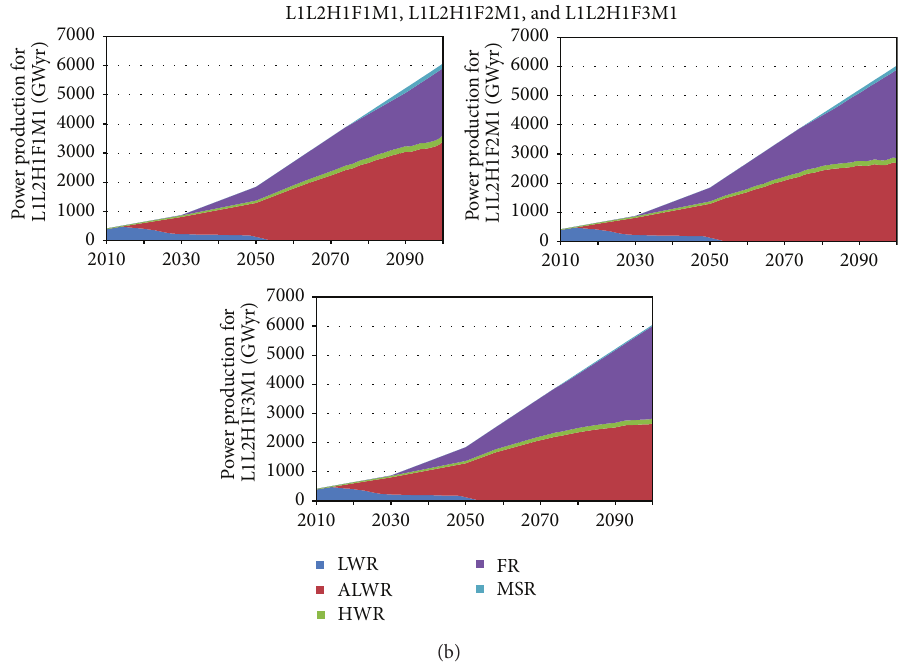
Figure 1: Power production by NESs in considered NES evolution scenarios.